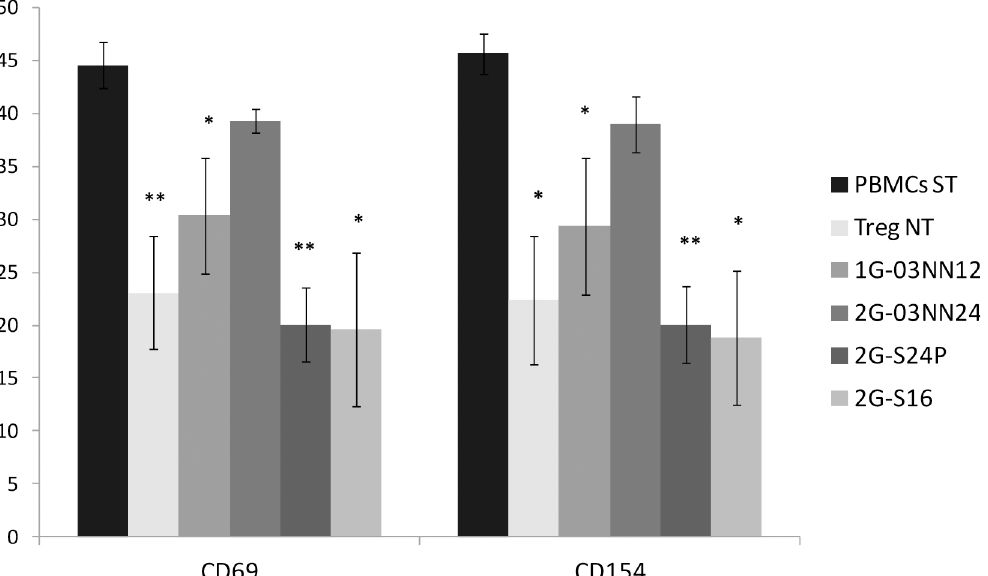
Fig 4. Suppressive capacity of Treg cells treated with dendrimers. Mean + SEM of the percentage of CD69 and CD154 activation markers in stimulated allogeneic PBMC alone (PBM ST) and co-cultured with Treg cells treated or non-treated (Treg NT) with cationic or anionic dendrimers (Treg: PBMC ratio of 1:1). Treg NT (n = 5), 1G-03NN12 (n = 4), 2G-03NN12 (n = 3), 2G-S24P (n = 5) and 2G-S16 (n = 3). ** p < 0.01; * p < 0.05 with the Mann Whitney